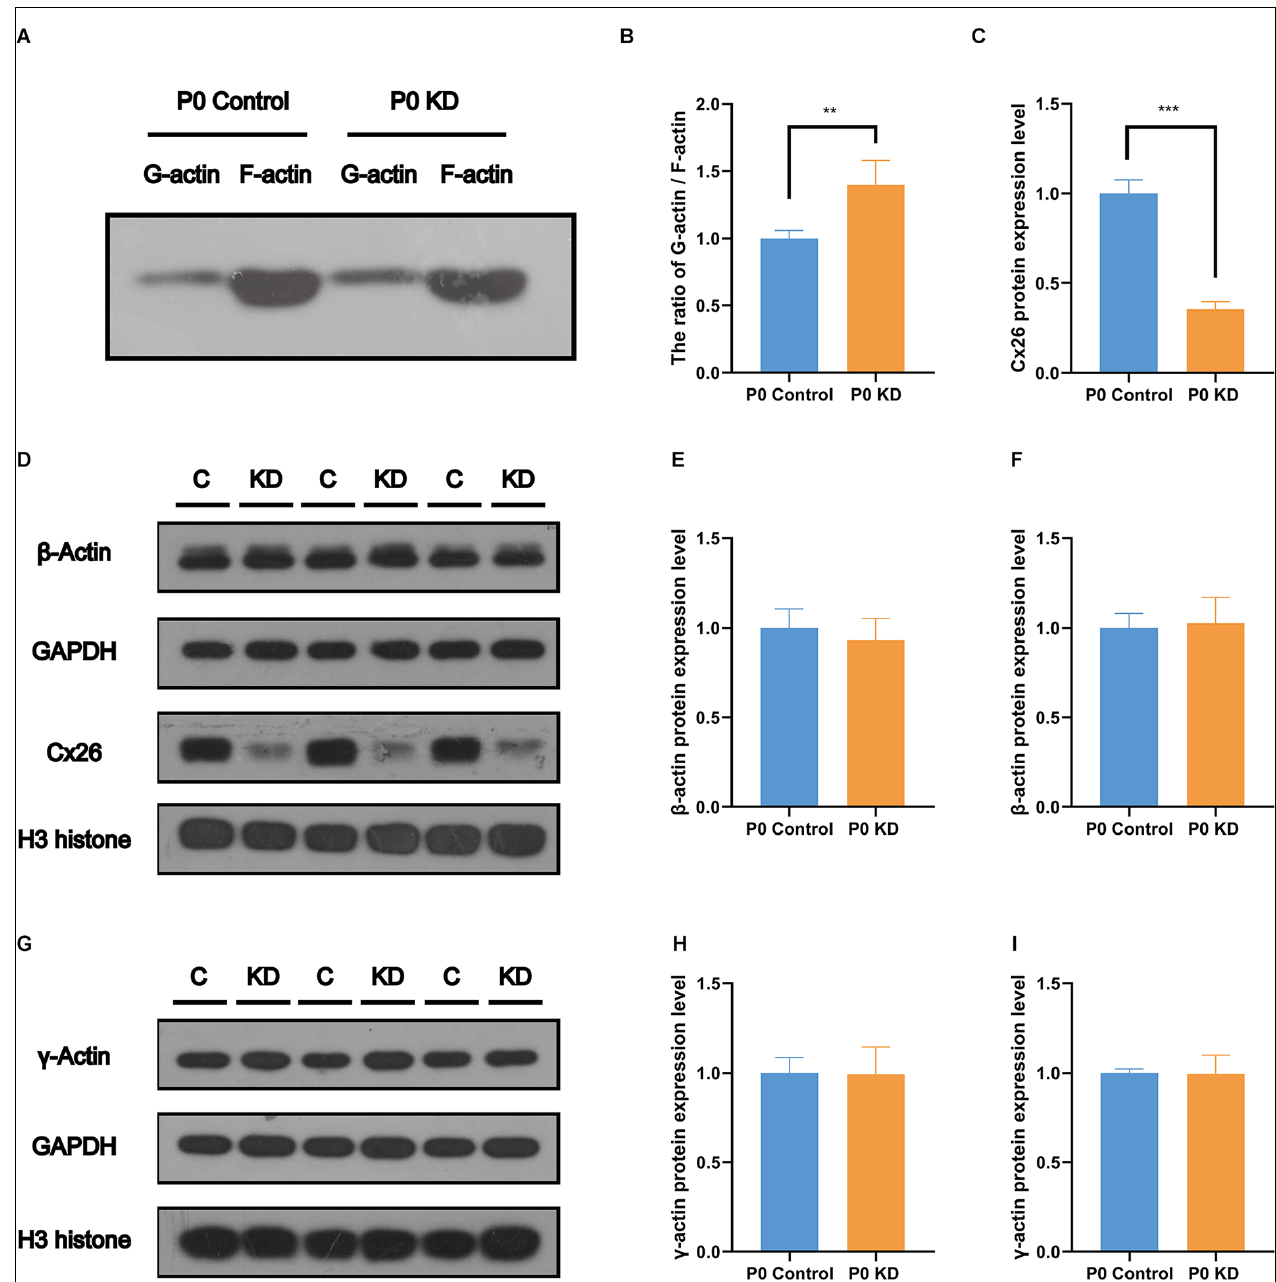
FIGURE 5 | No change was found in the protein expression level of G-actin. Protein expression level of Cx26, β -actin (A) , and γ -actin (E) in P0 control and P0 KD groups. β -actin and γ -actin protein expression level in cochlear of Cx26 KD mouse models. The ratio of G-actin/F-actin in P0 control and P0 KD group (B) respectively. Western blotting F-actin and G-actin in Western blot results of protein expression level of Cx26, β -actin (D) and γ -actin (G) in P0 control and P0 KD groups. Camparison of relative Cx26 (C) , β -actin (E,H) , and γ -actin (F,I) protein expression in P0 control and P0 KD groups. GAPDH (C,E,H) and H3 (F,I) was used as the control, respectively. The differences of β -actin and γ -actin expression level between the P0 KD and the P0 control group were not significant ( P > 0.05). ***Significant difference from the control group ( P < 0.001). **Significant difference from the control group ( P < 0.01).